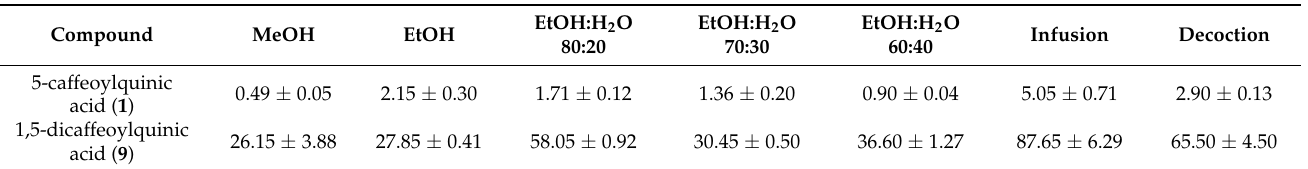
Table 1. Quantitative results of compounds 1 and 9 (mg/g extract ± SD) in extracts of C. cardunculus subsp. scolymus